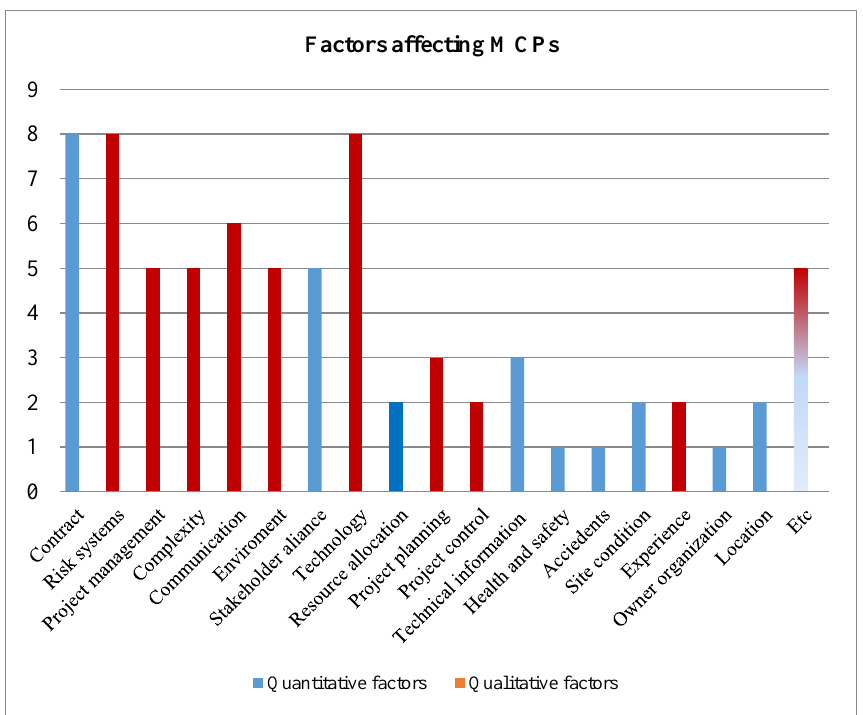
Figure 8. Degree of agreement among authors about the Factors affecting MCPs.“Source: